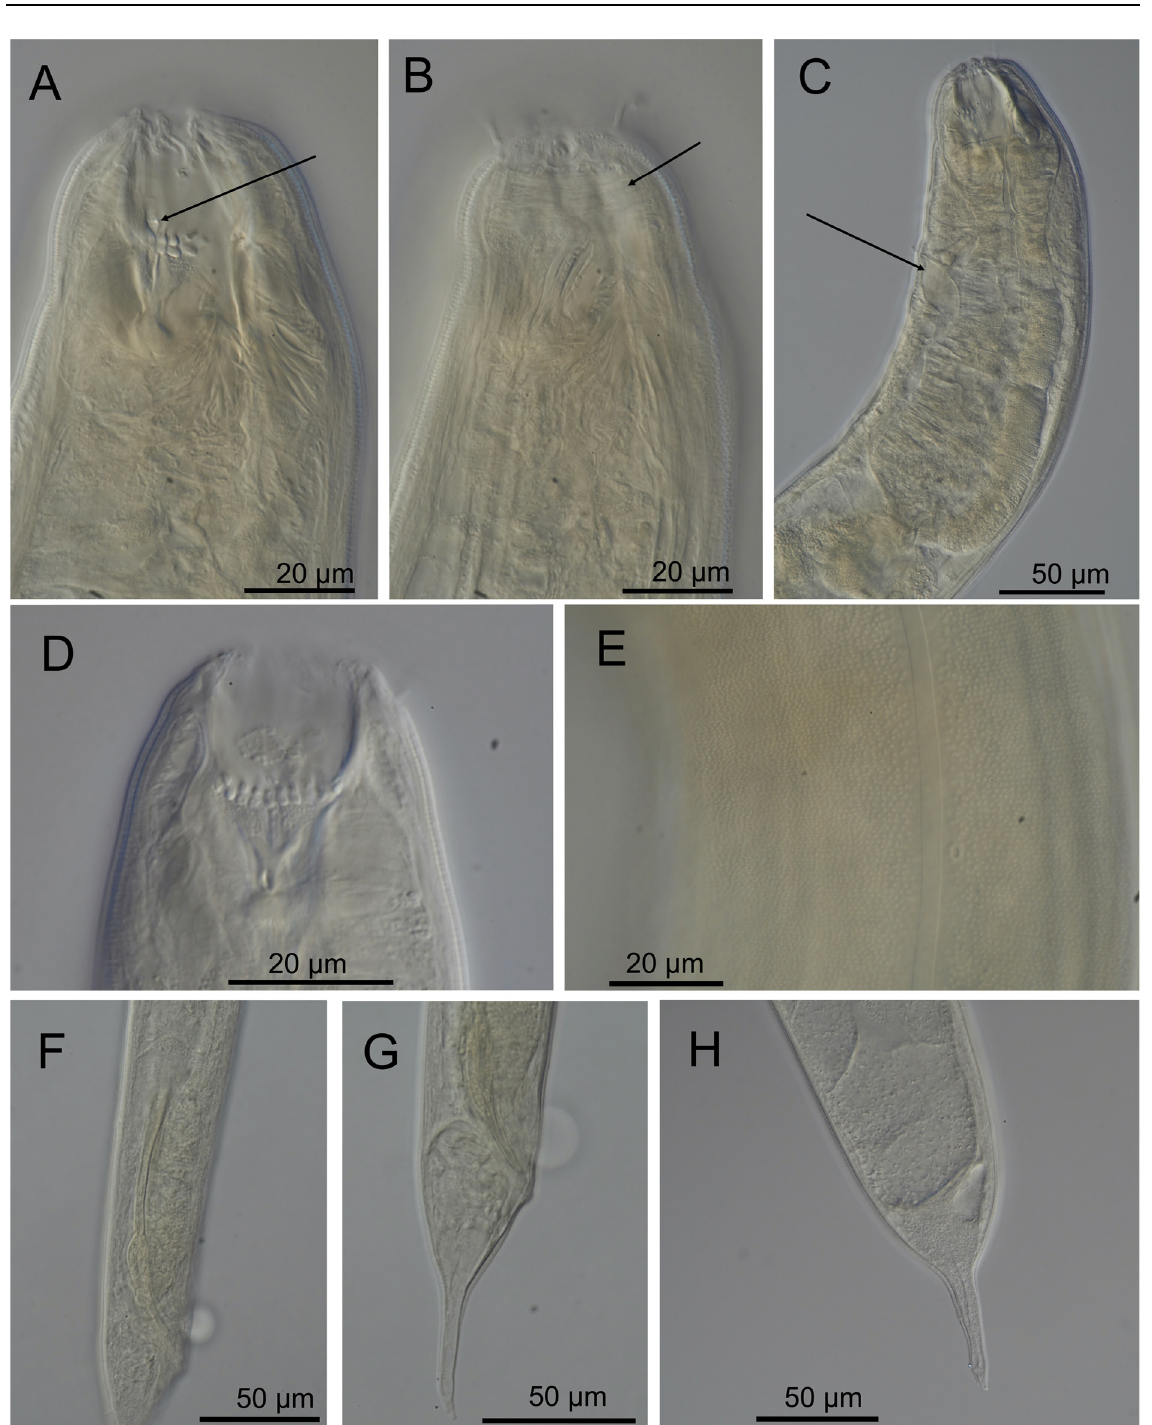
Fig. 5. Cobbionema cylindrolaimoides Schuurmans Stekhoven, 1950. Light micrographs. A . Female stoma showing stoma armament, arrow pointing to the right ventrosublateral tine (SMNH-179211). B . Anterior part of a female showing sphincter muscle surrounding the anterior stoma chamber (arrow) (SMNH-179212). C . Anterior part of a female with arrow showing the ampulla of the secretory-excretory system (SMNH-179211). D . Male stoma showing buccal armament (SMNH-179213). E . Cuticle showing lateral ala (SMNH-179211). F . Caudal region of a male showing spicule and crura (SMNH- 179214). G . Male tail (SMNH-179214). H . Female tail